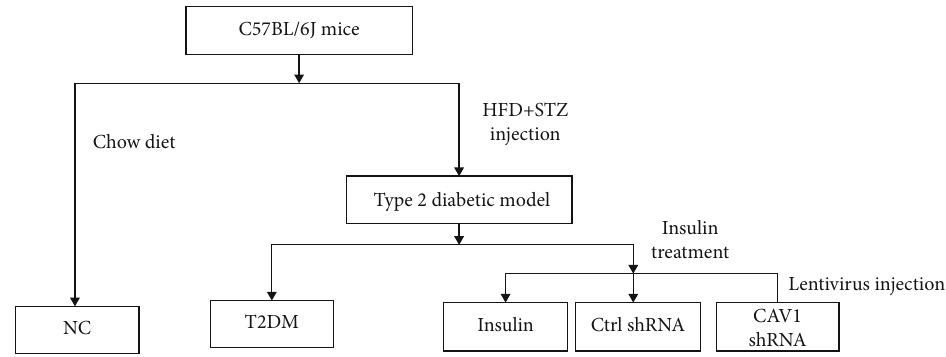
Figure 1: Flow chart of the experimental design.